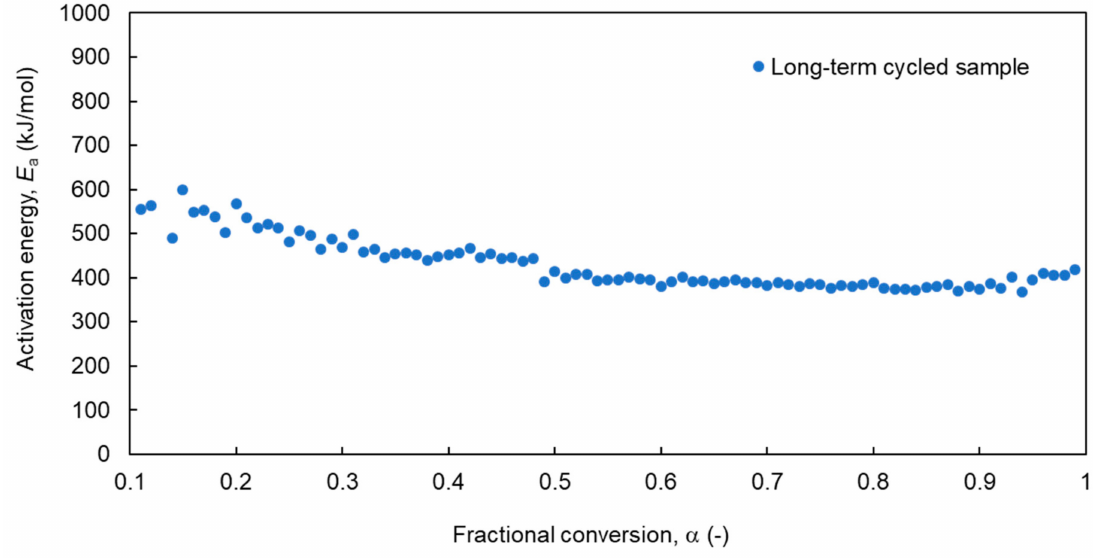
Figure 4. Variations in the apparent activation energy, E a , of the long-term cycled sample against the fractional conversion of α during the HC mode. The values were calculated and plotted with ∆ α = 0.01 to check the transition of the reaction model with progress of the reaction extent of the HC